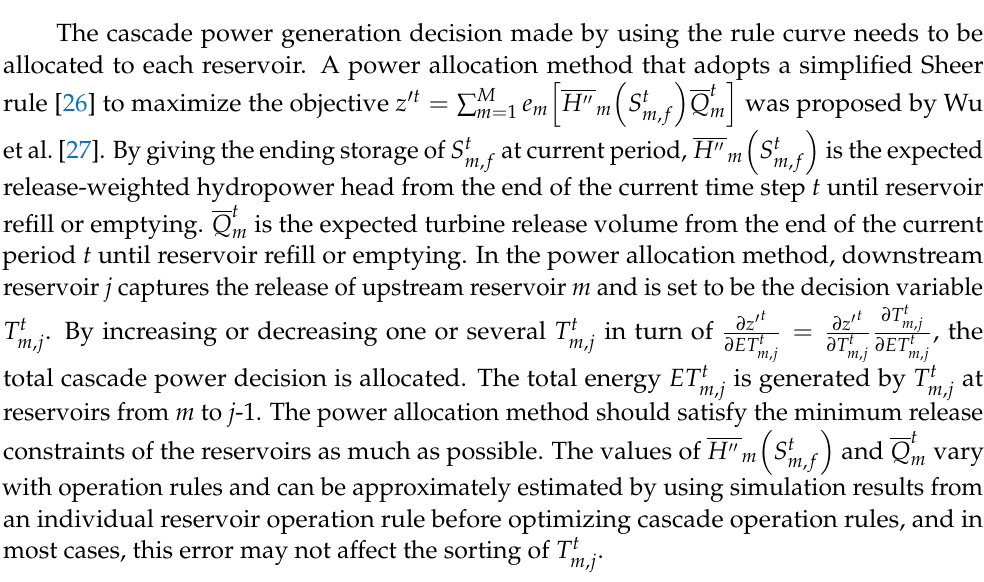
Figure 1. Three-segment rule curve.